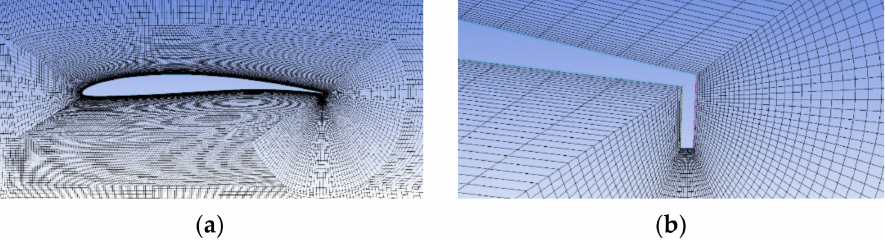
Figure 11. Computation grid of the cross-sectional airfoil with a Gurney flap: ( a ) Grid around the airfoil; ( b ) Grid near the Gurney